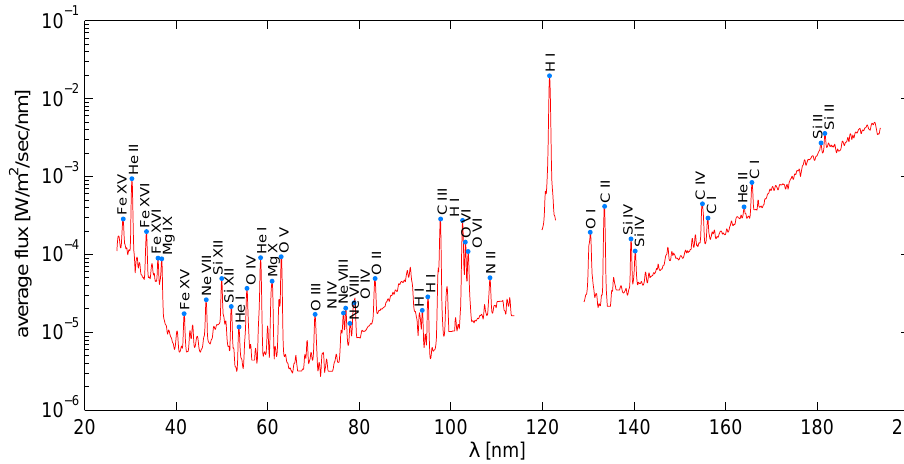
Fig. 2. Time-averaged EUV spectrum from the EGS instrument. The 38 strong spectral lines are highlighted.